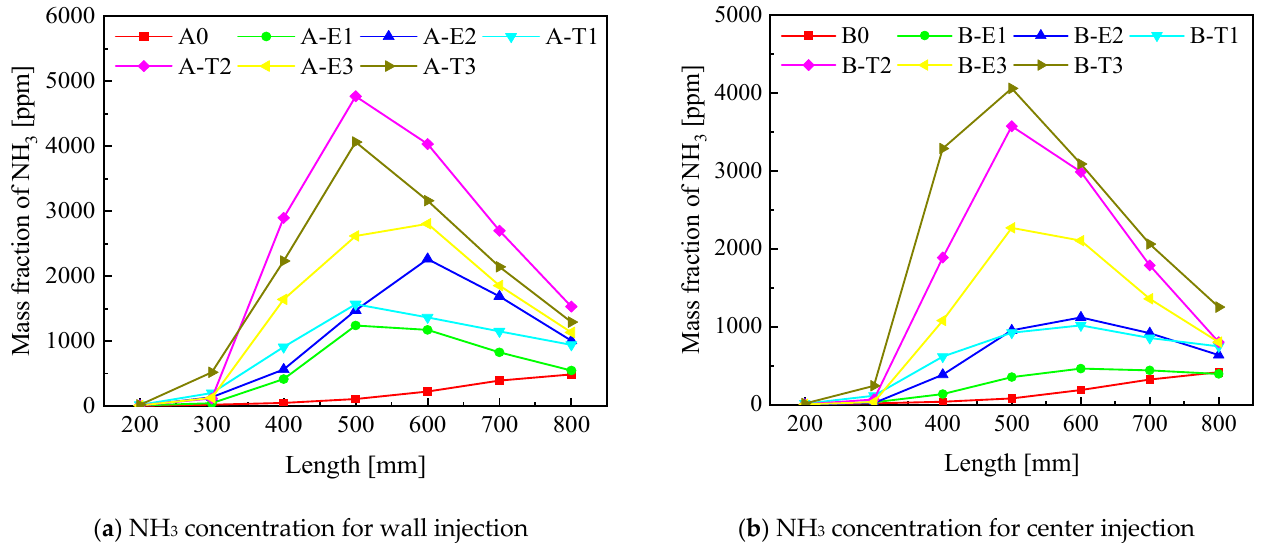
T3 Figure 7. The NH 3 volume-averaged concentration. 3.3. NH 3 Distribution Uniformity The increase in NH 3 concentration is not evenly distributed. The ammonia produced may not react fully with NO x and escape. Thus, the uniformity of NH 3 concentration in the SCR system should be considered. Figure 8 shows the NH 3 concentration uniformity index at 0.1 s. In contrast to Case A0 and Case B0, using mixer cases has improved uniformity at various positions in the pipeline to varying degrees. As for wall injection in the E-type mixer, the pre-mixer, post- mixer, and dual-mixer cases improve the uniformity index by 38.5%, 62.2%, and 104.3%,